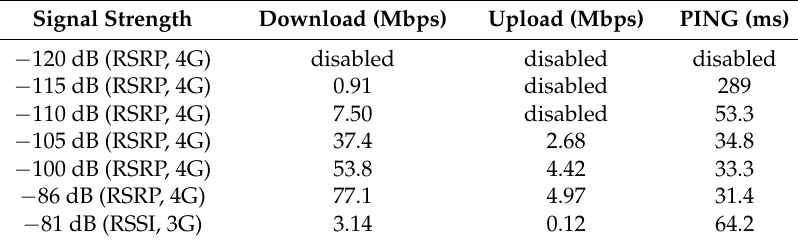
Table 1. Data transfer rate per signal